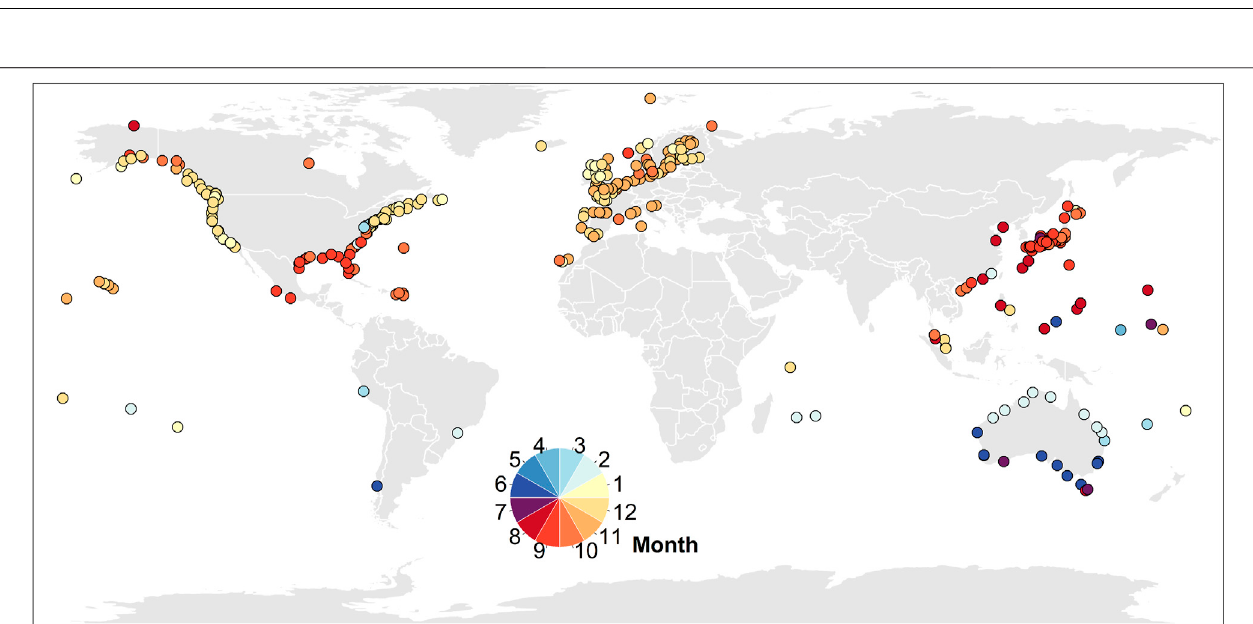
FIGURE 3 | The month with the most frequent concurrences of extreme precipitation and extreme storm surge exceeding the 90th percentile values.